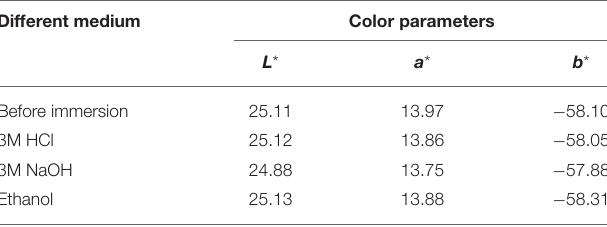
TABLE 3 | Color parameters of the film before and after being immersed into 3M HCl, 3M NaOH and ethanol for 72h, respectively. Different medium